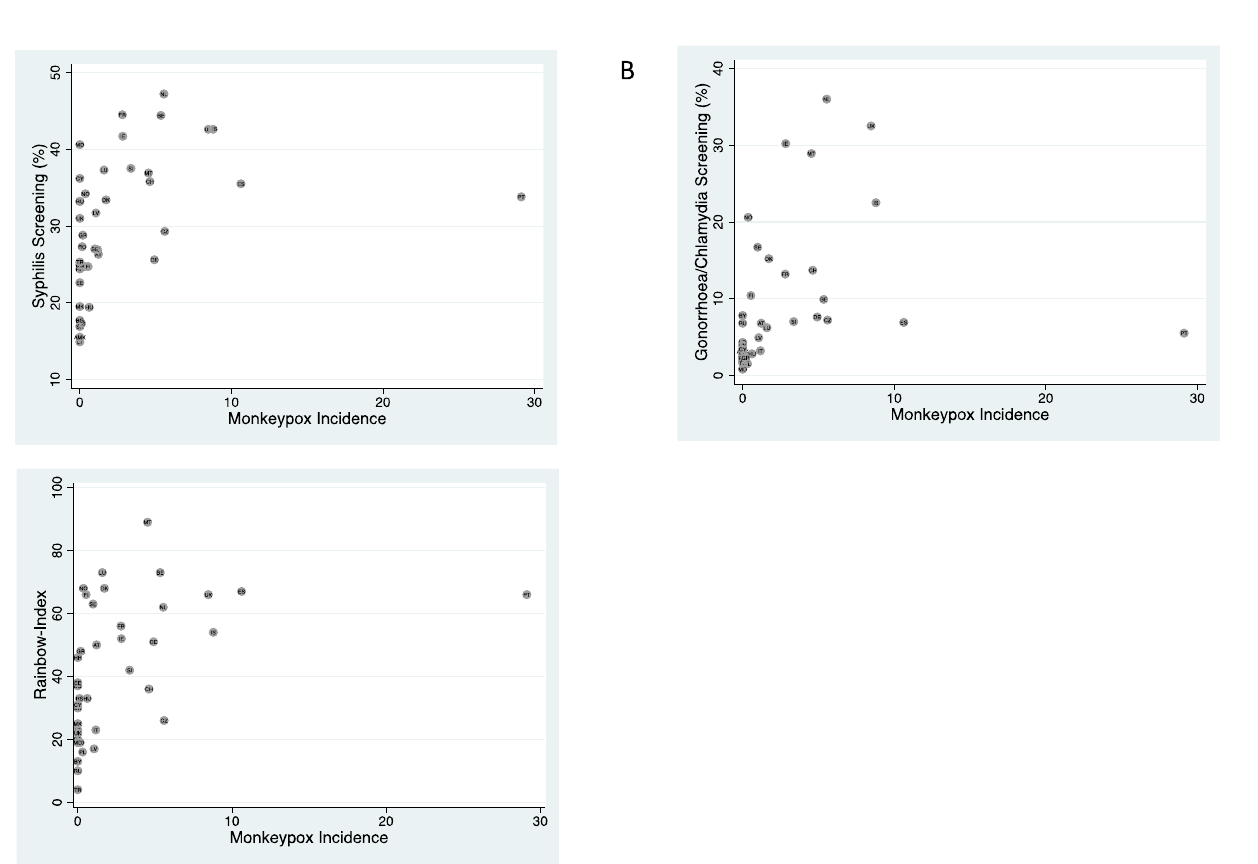
Figure 1. Scatter plot of country-level cumulative incidence of MPX (cases per million 6 May 2022–21 June 2022) and intensity of syphilis screening ( A ), chlamydia/gonorrhoea screening ( B ) and the Rainbow Index ( C ).